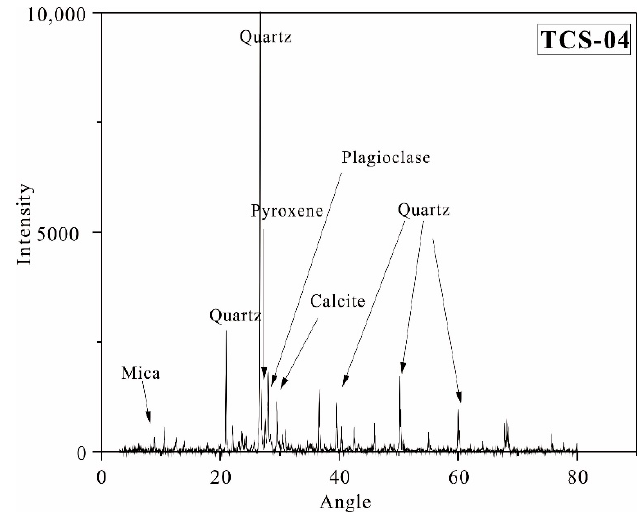
Figure 1. XRD pattern of uranium ore.